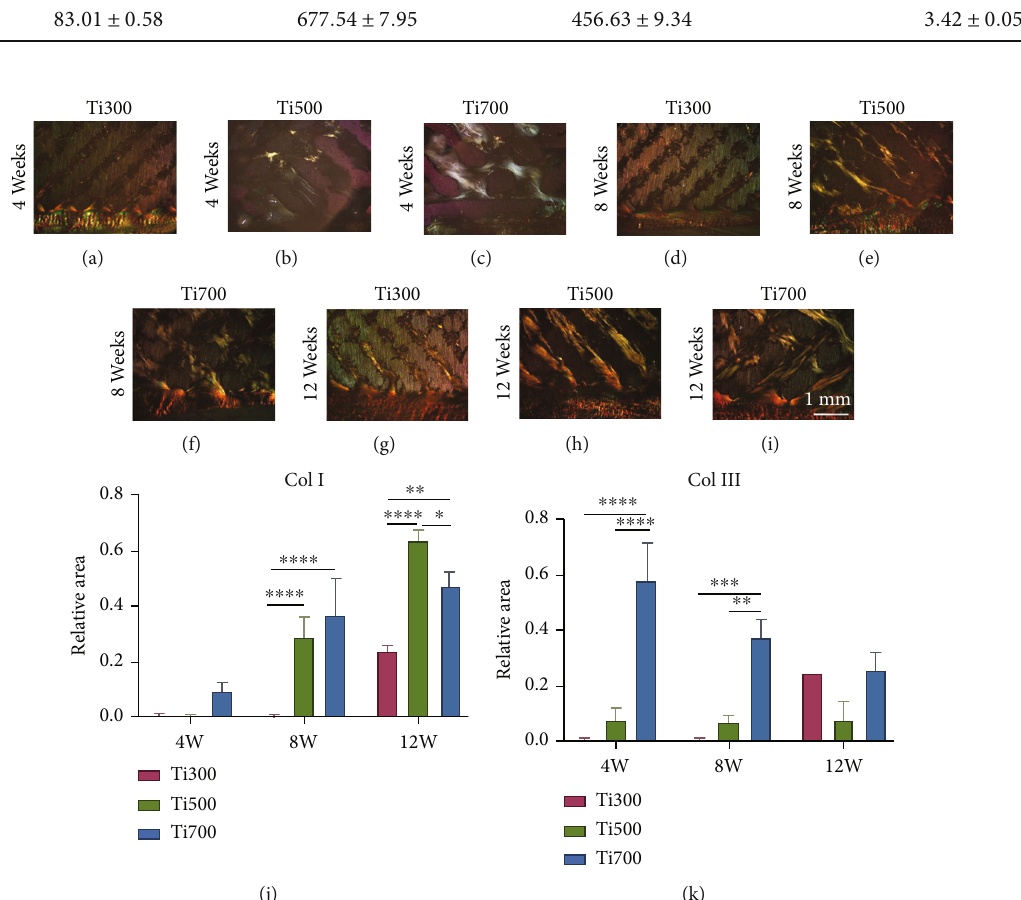
Figure 4: Improvement in collagen composition. (a) – (i) Representative images of Sirius red-stained sections. (j) Statistical analysis of the type I collagen area in pores ( n = 5 ). (k) Statistical analysis of the type III collagen area in pores ( n = 5 ).